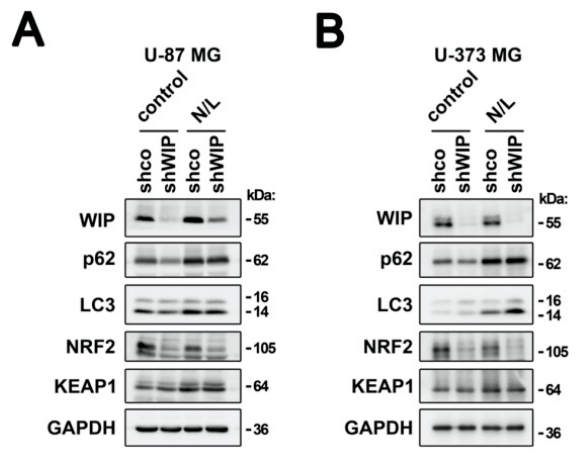
Figure 4. WIP does not regulate KEAP1 degradation. Immunoblots of WIP, p62, LC3, NRF2, KEAP1, and GAPDH as a loading control of U-87 MG ( A ) and U-373 MG ( B ) glioblastoma cells that were transduced with lentiviral vectors containing shco or shWIP and then treated with a standard cocktail of ammonium chloride and leupeptin (N/L), to 20 µM and 100 µM, respectively, during 24 h.